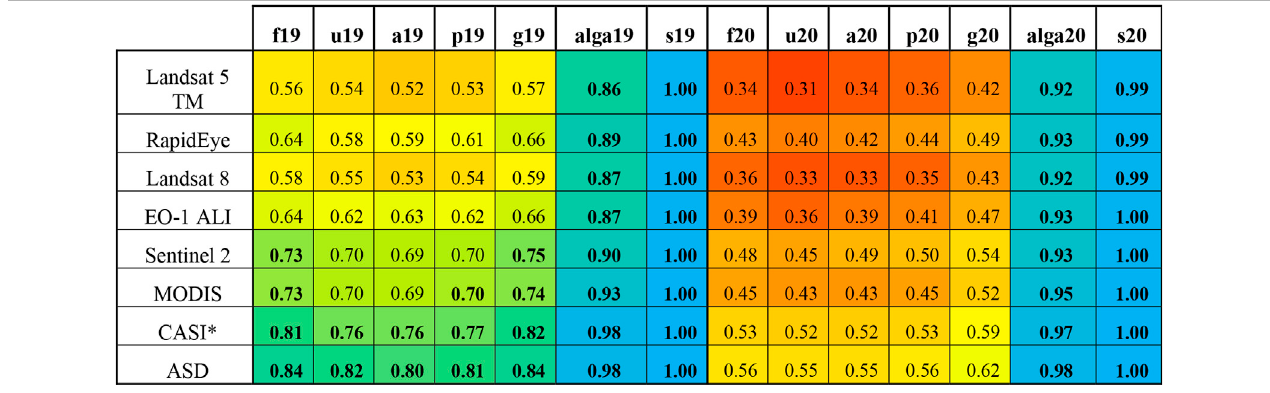
TABLE 2 | Maximum LNN values for each grouping and year for the original (ASD) spectra and all resampled spectra. Multi and hyperspectral sensors to which the spectra wereresampledareorderedbyincreasingspectralinformation(No.bands).Cellshavebeencolouredaccordingtotheirvalueforrapidinterpretation(gradient:red (cid:1)